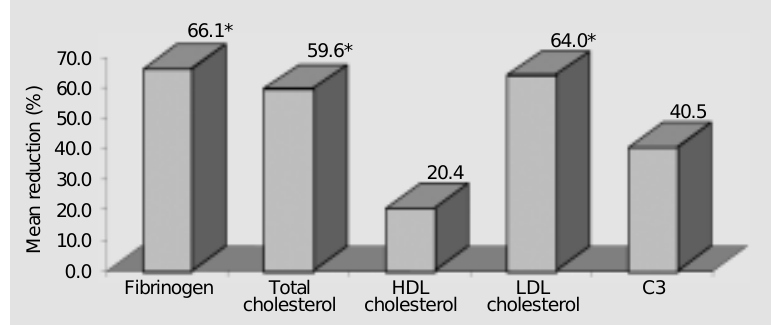
Figure 2. Mean reduction (%) of each parameter before and after a session. *P<0.05 when comparing values before and after a session (chi-square